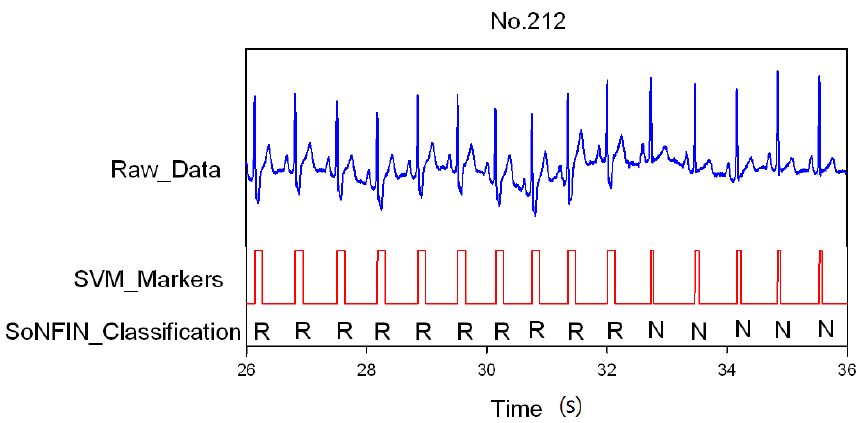
Figure 4. SVM marks the heartbeats of ECG, and then SoNFIN classifies the RBBB and NSR beats for file No. 212, in which “R” and “N” denotes RBBB and NSR, respectively.